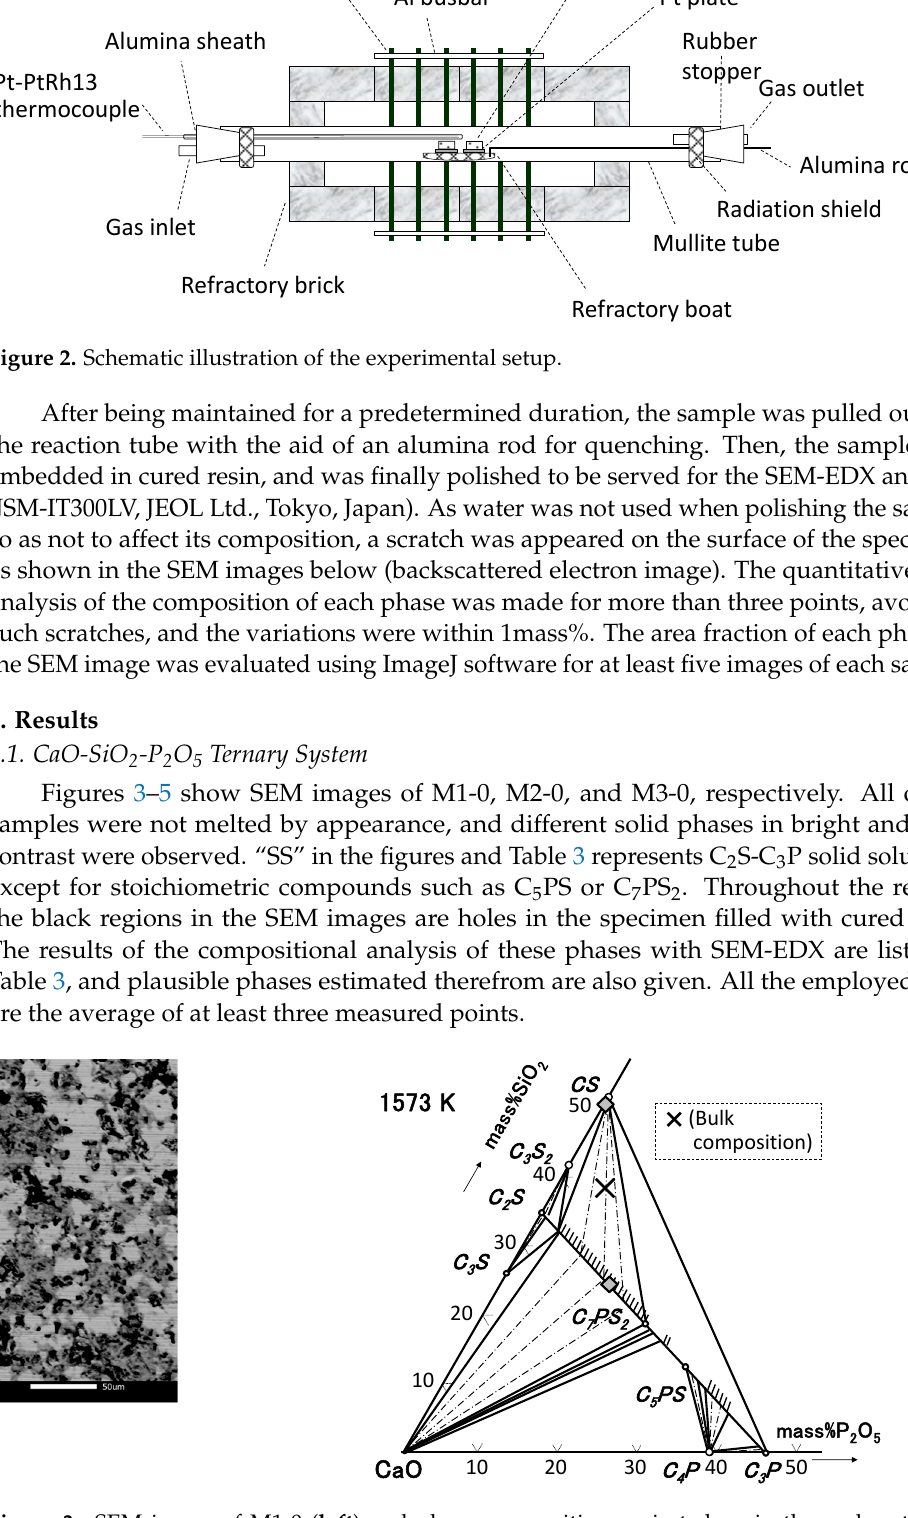
Figure 3. SEM image of M1-0 ( left ) and phase composition projected on isothermal section of CaO-SiO 2 -P 2 O 5 ternary phase diagram at 1573 K ( right